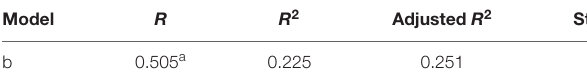
TABLE 3 | Model summary and ANOVA test of regression analysis. Model